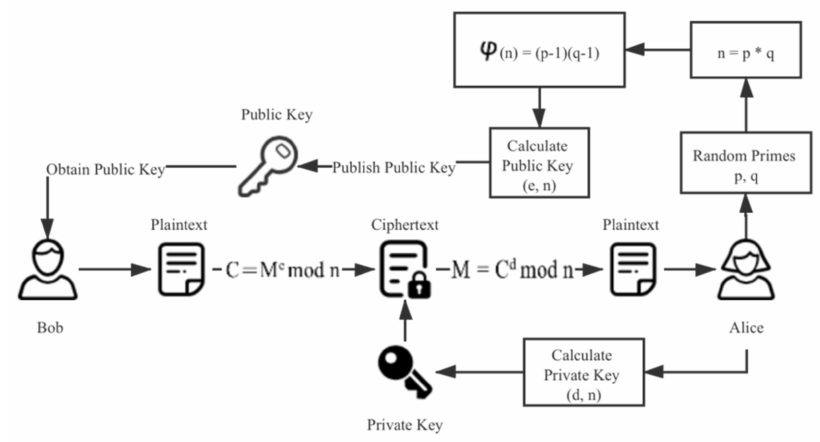
Figure 4. RSA algorithm